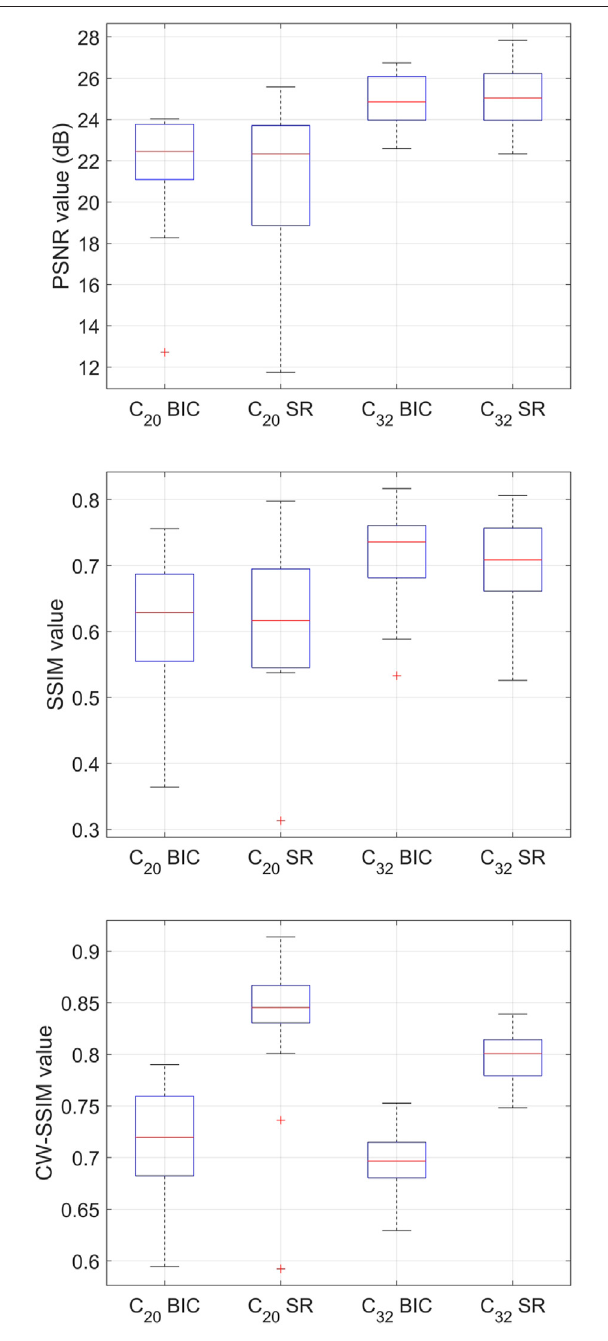
FIGURE 3 | Similarity of interpolated and super-resolution images computed according to the PSNR (top), SSIM (middle) (Wang et al., 2004), and CW-SSIM (Sampat et al., 2009) (bottom) metrics.